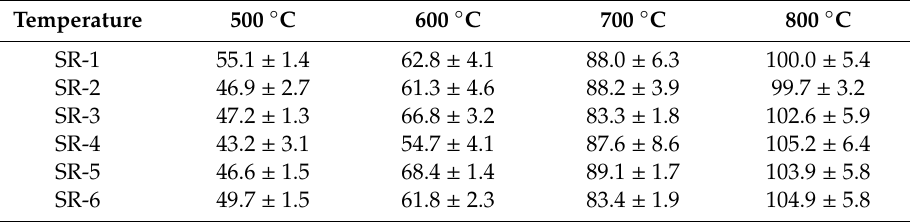
Table 4. Carbon balance (out / in) resulting from combustion of composites,